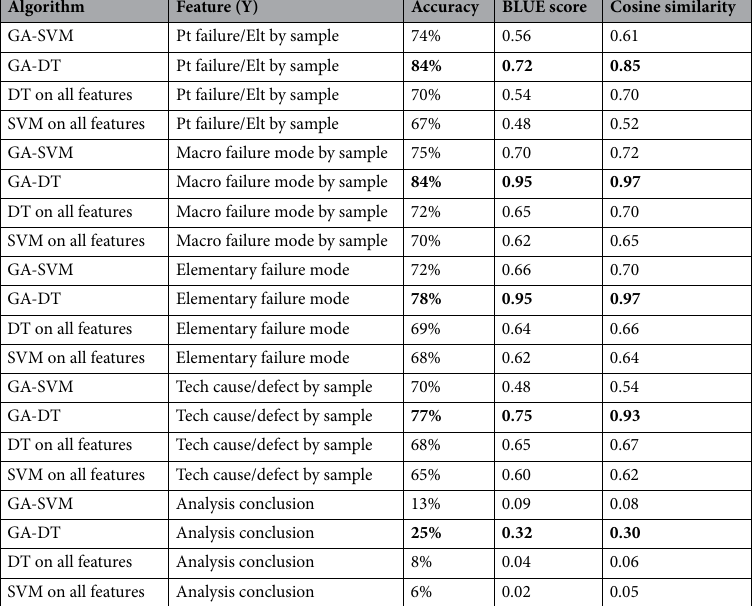
Table 3. Values of the accuracy, BLEU scores, cosine similarities for both GA-SVM and GA-DT algorithms. A higher value of these metrics signifies a better predictive model within the conclusion of failure. Significant values are given in